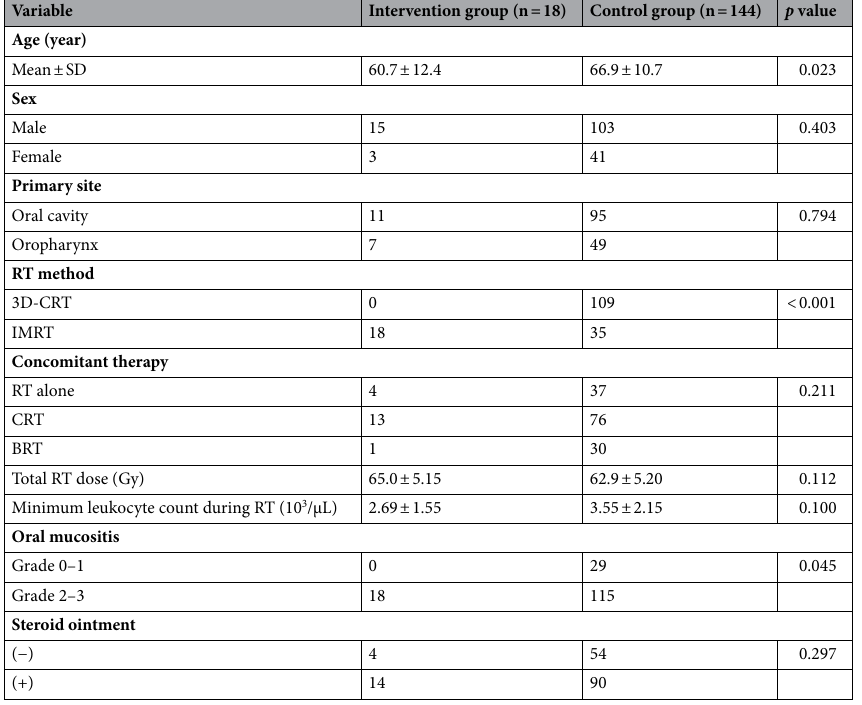
Table 1. Patient characteristics of the intervention and control